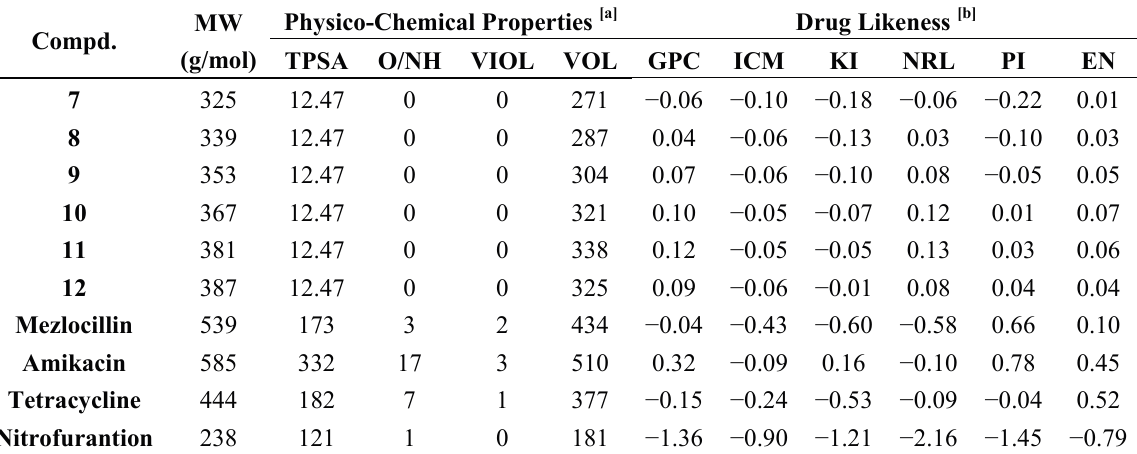
Table 5. Molinspiration calculations of compounds 7 – 12